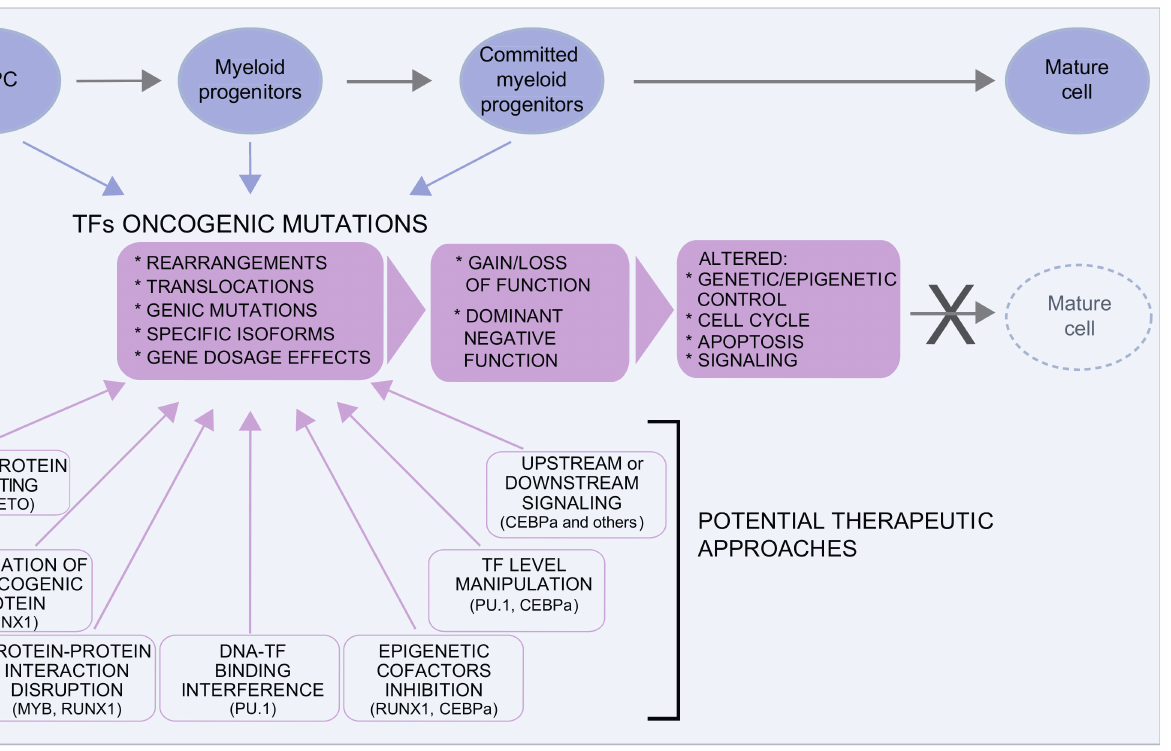
Figure 5. Transcription factors in MDS/AML. Several transcription factors are involved in MDS and AML. Oncogenic mutations are very heterogeneous and can result in gain or loss of function or in dominant negative effects, often with a pleiotropic effect on the control of the equilibrium between proliferation and differentiation. Although traditionally considered “undruggable” factors, in the last years, several approaches have been envisaged to either target the oncogenic protein or to restore the level/function of the TF. Some examples in this direction are discussed in the text and illustrated